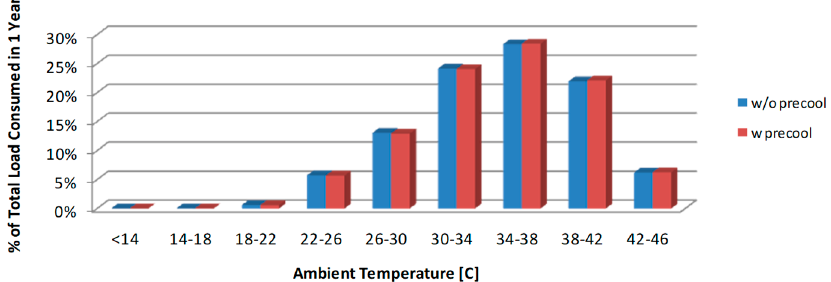
Figure 5. Supermarket in Phoenix, AZ, USA: Percentage of annual building load that is delivered in each temperature bin.